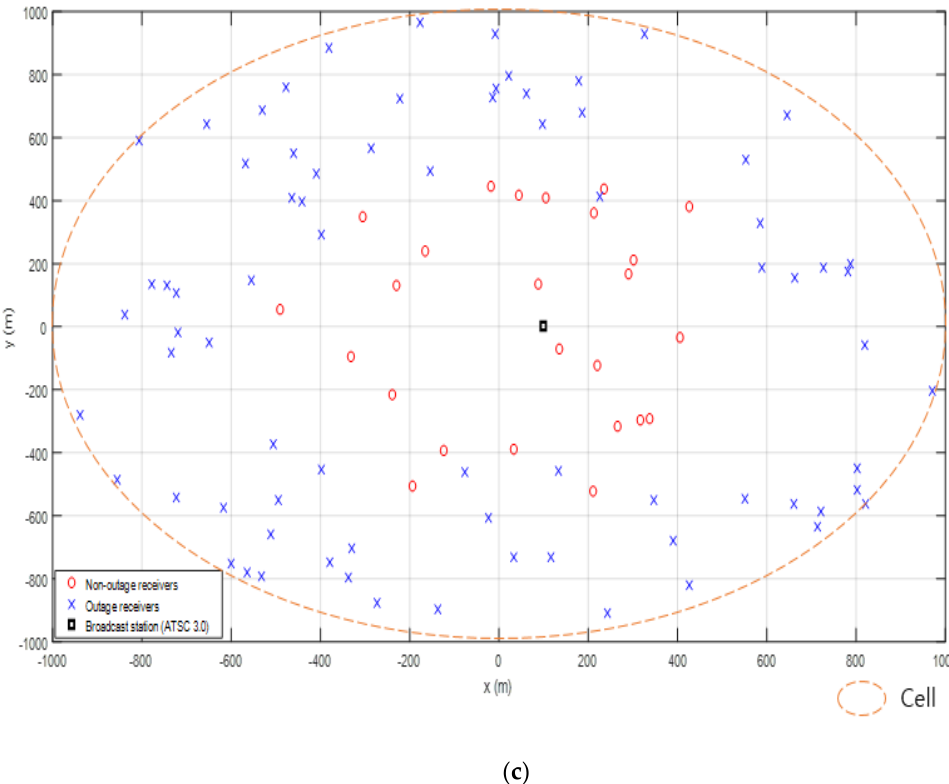
Figure 8. The outage-state comparison of the proposed, the 5G, and the ATSC 3.0 emergency alert broadcasts after the first broadcast. ( a ) shows the outage states for the proposed broadcast. This broadcast approach relies on the 5G and ATSC 3.0 convergence network of Figure 6. In the first broadcast, the 5G base station and the ATSC 3.0 broadcast station broadcast the CBS and the AEA messages, respectively. ( a ) reveals that the 60 receivers correctly decode the CBS message or the AEA message. Therefore, the success rate is 60% in the first broadcast case. ( b ) exhibits the outage states for the 5G CBS broadcast, which just relies on 5G cellular networks. The success rate is 43% in ( b ). ( c ) shows the outage states for the AEA message broadcast, which just relies on ATSC 3.0 networks. The success rate is 25% in ( c ). Since the users can receive the CBS message or the AEA message in the convergence network, the success rate of the proposed method is much higher than those of the 5G and the ATSC 3.0 cases.